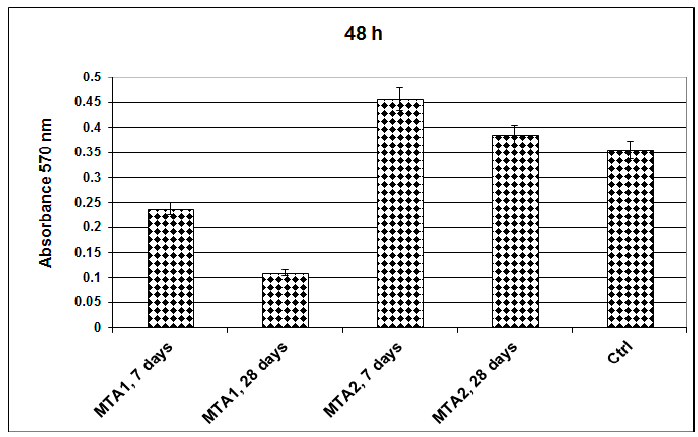
Figure 13. Endothelial cells proliferation profiles after growing on control (ctrl) and MTA for up to 48 h.